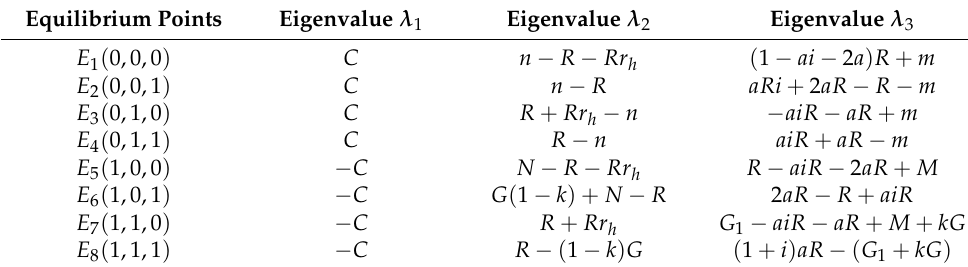
Table 3. System equilibrium points and